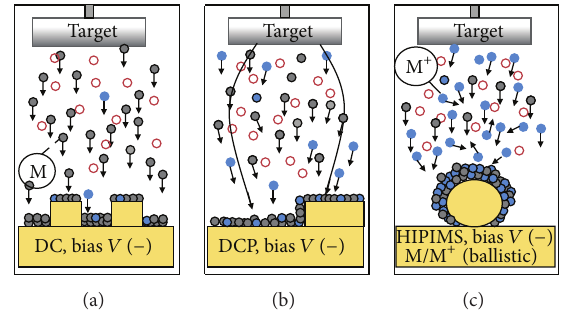
Figure 7: Scheme for the magnetron chamber induced M + ion- ization by (a) DC, (b) DCP, and (c) HIPIMS sputtering of metal- ions (M + ) on 3D substrates showing the higher density ionization induced by